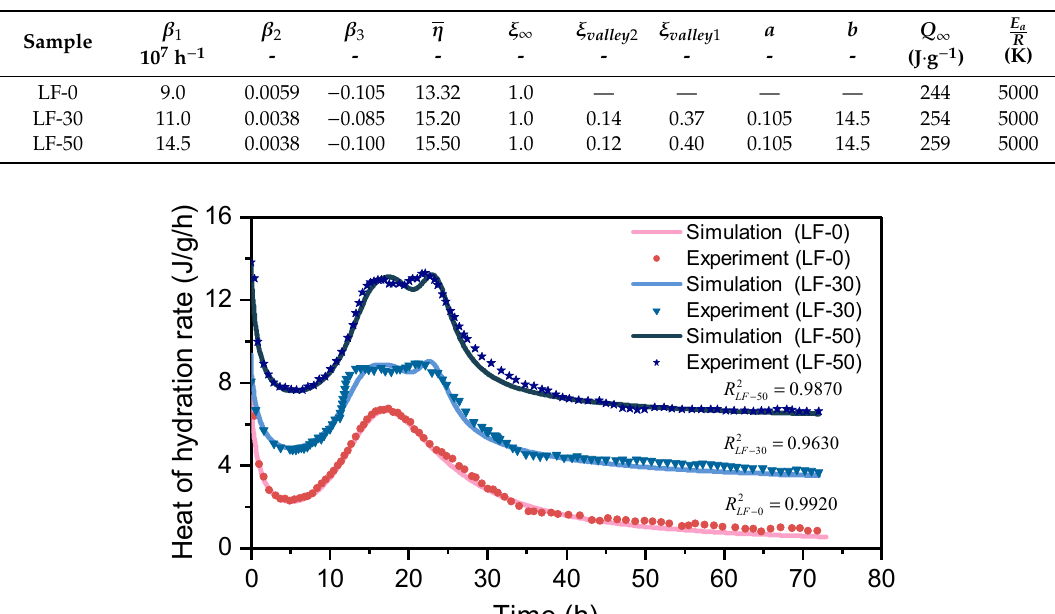
Figure 7. The evolution process simulation of the heat of hydration rate in LF-0, LF-30, and LF-50.